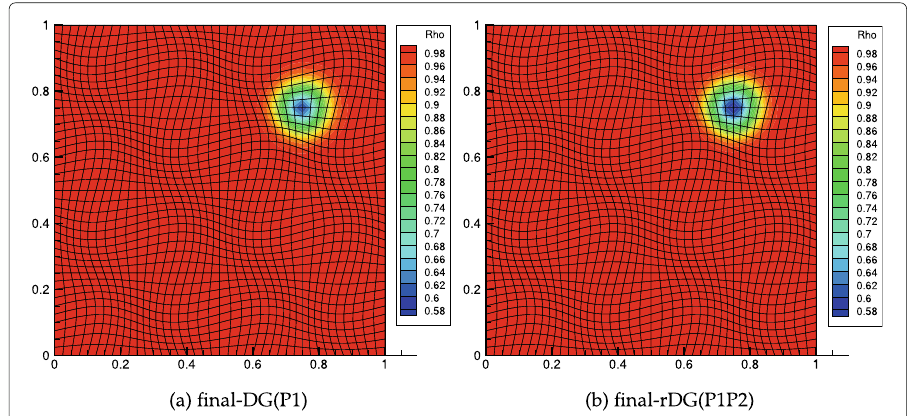
Fig. 4 Computed density for DG(P1) and rDG(P1P2) discretizations of the isentropic vortex